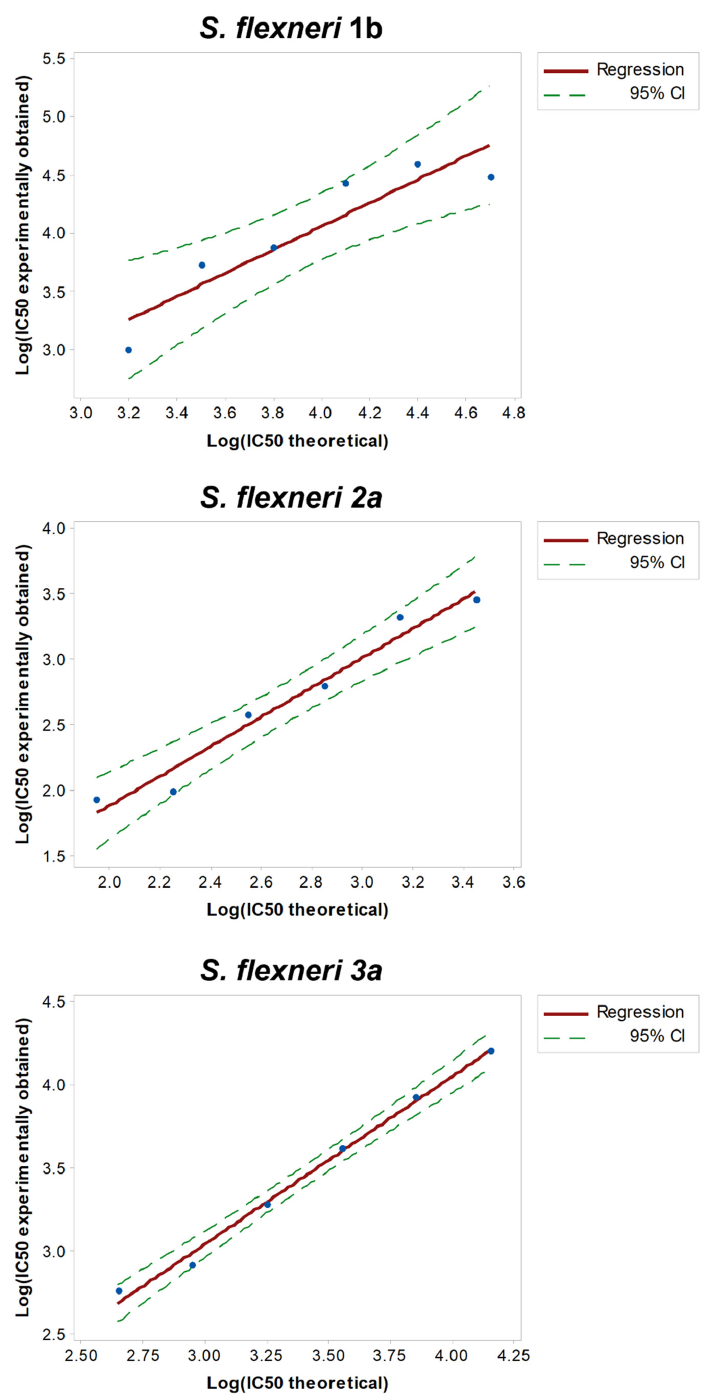
Figure 3. Linearity. Log (IC50 theoretical) obtained for each sample versus Log (IC50 experimentally obtained). Single datapoints are indicated with blue dots. The red solid line represents the linear regression and the green dashed lines the 95% confidence interval